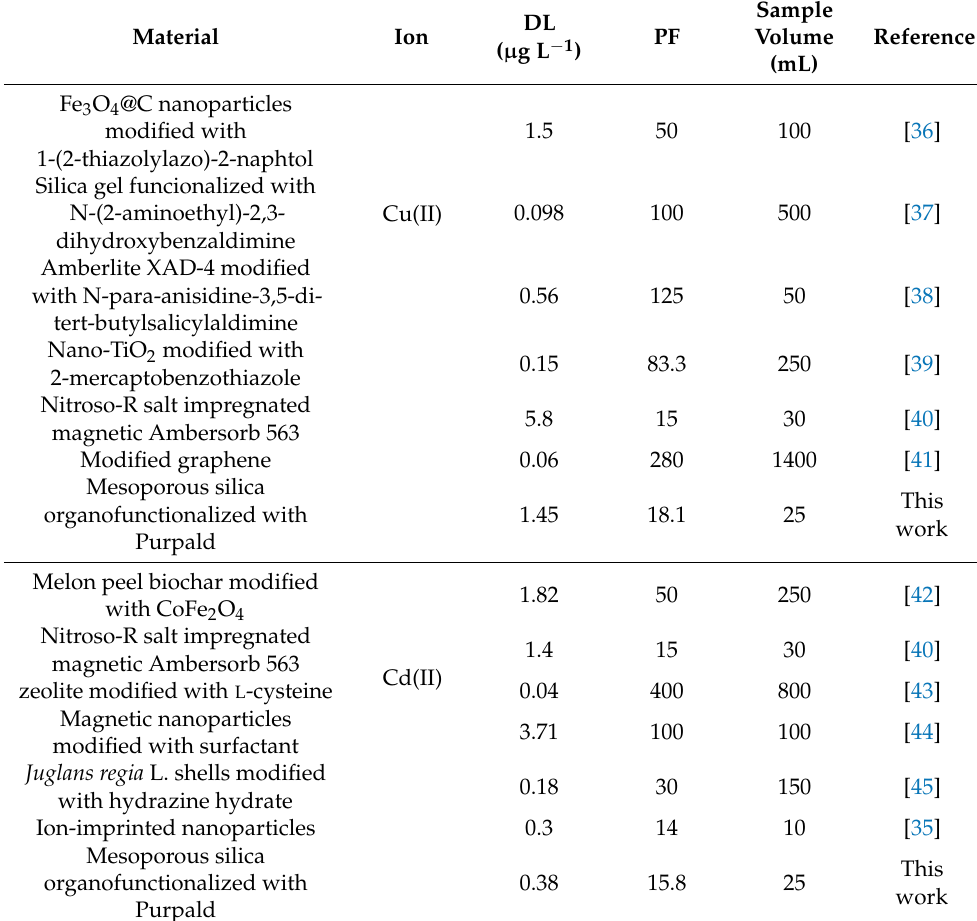
Table 9. Major analytical features of distinct SPE methods for the determination of Cu(II) and Cd(II).